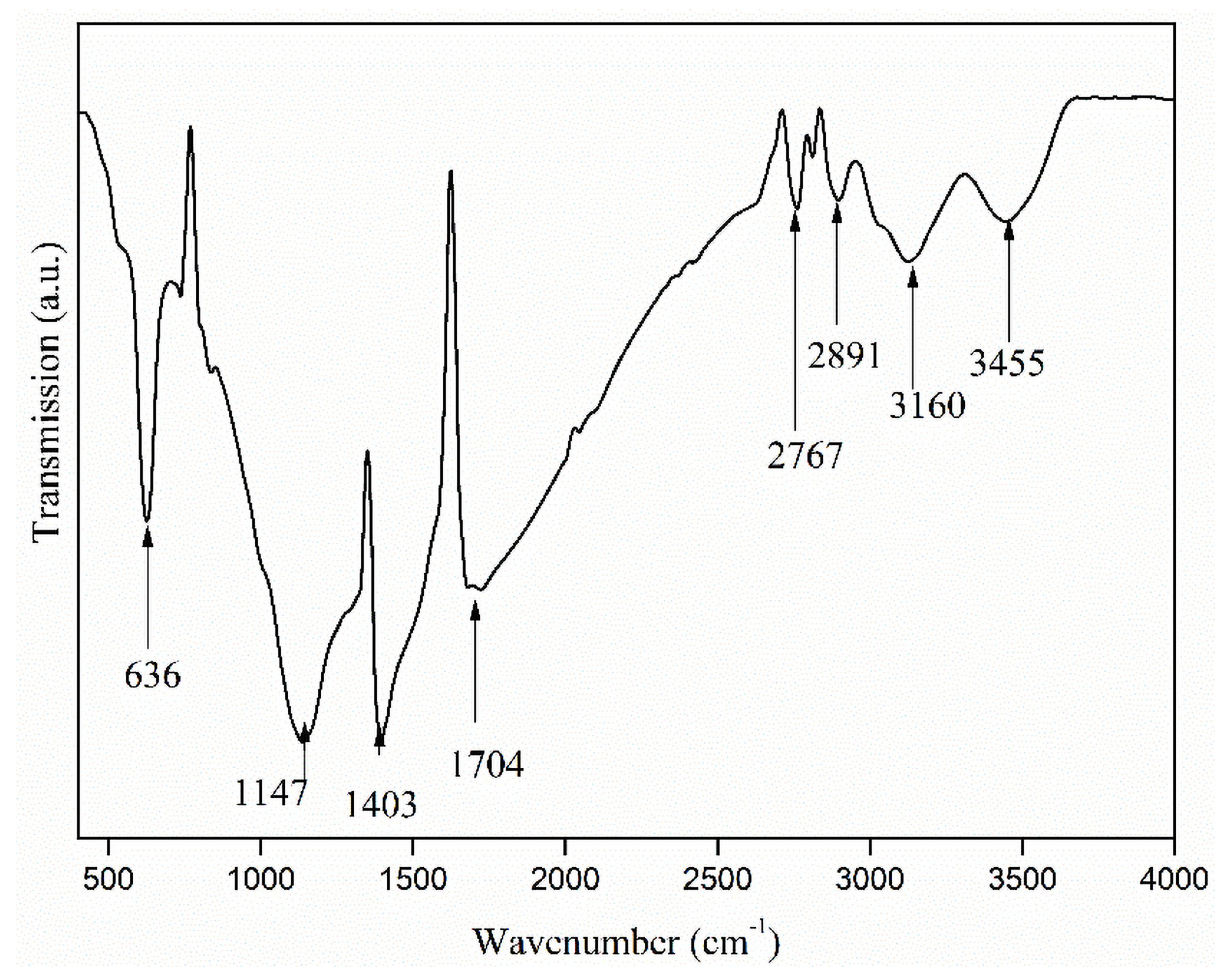
Fig 5. FTIR for the industrial waste